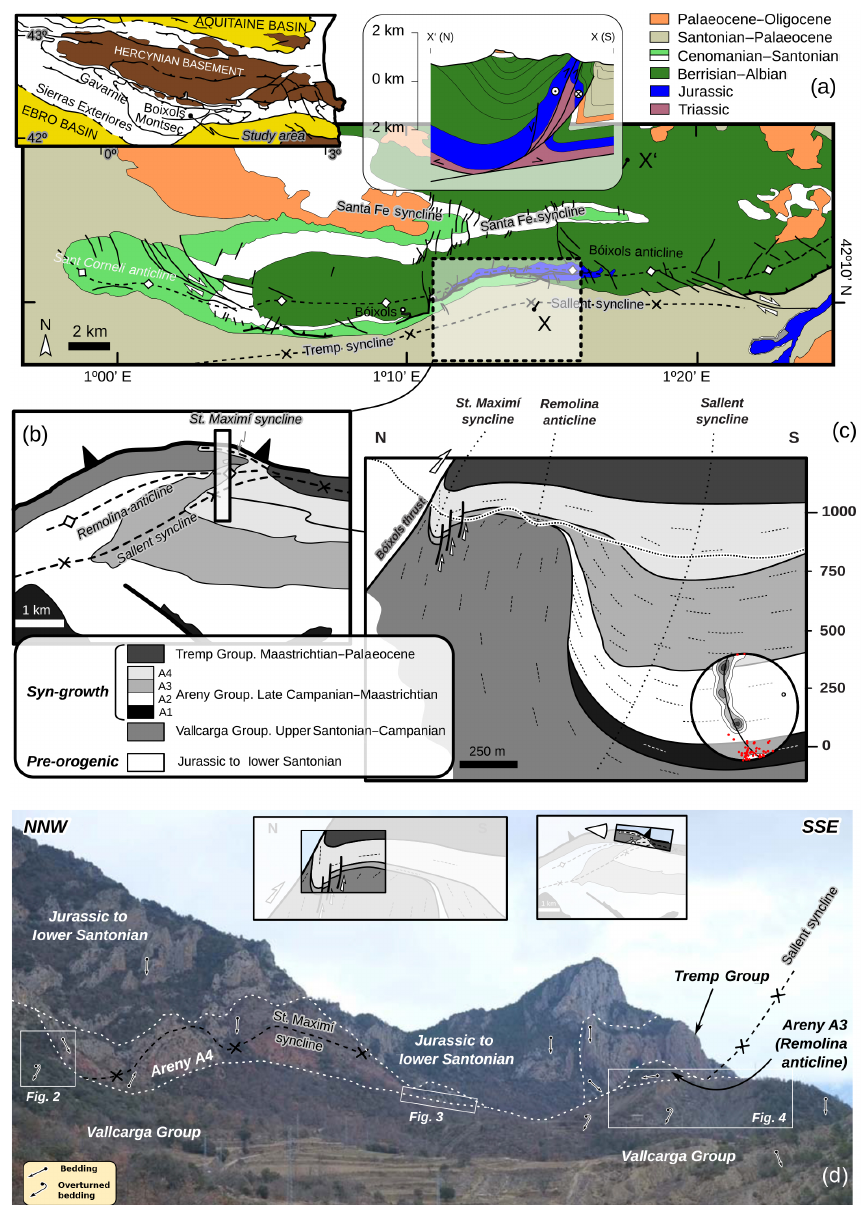
Figure 1. (a) Geological maps of the eastern Pyrenees, with detail and cross section (modified from García-Senz, 2002) of the Sant Corneli- Bóixols anticline. Geological map (b) and schematic cross section (c) of the study area, with cumulative contouring of poles to bedding and best-fit beta axis of syn-folding beds and poles of pre-folding beds (red circles). (d) Panoramic view of the study area, with insets showing the location of Figs. 2 to 4 and the photographed area in cross section and map view